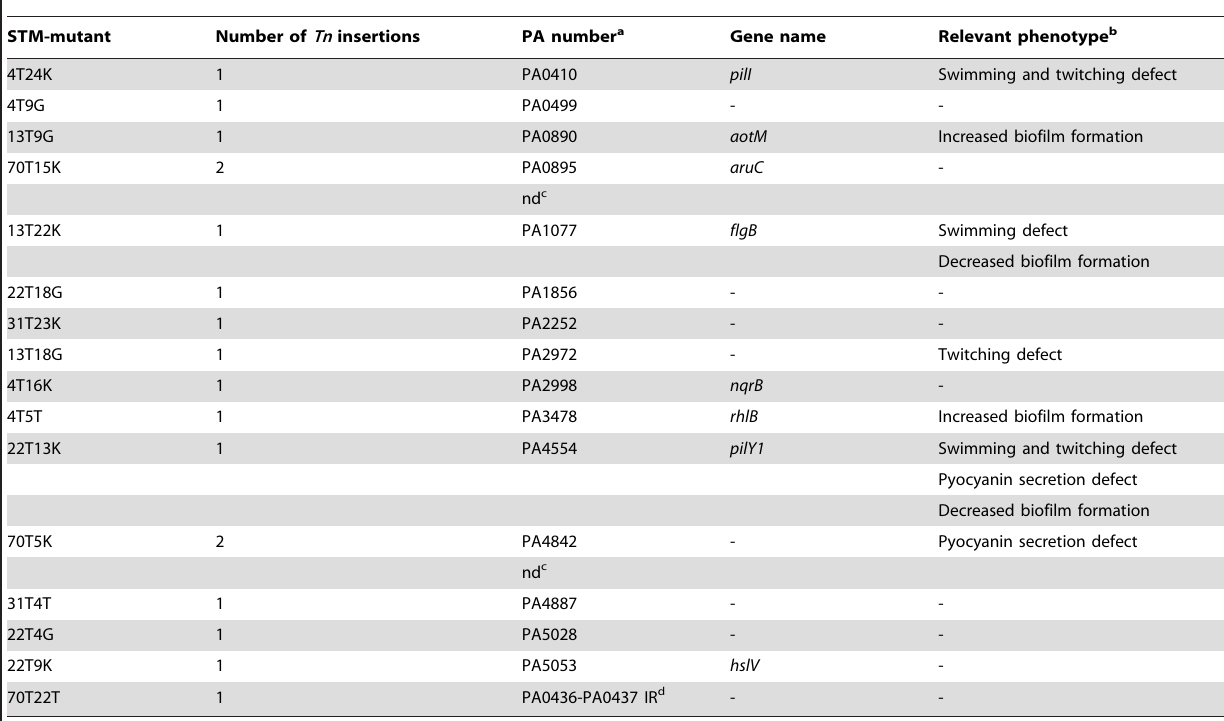
Table 1. Genotypic and phenotypic characterization of Pos-STM